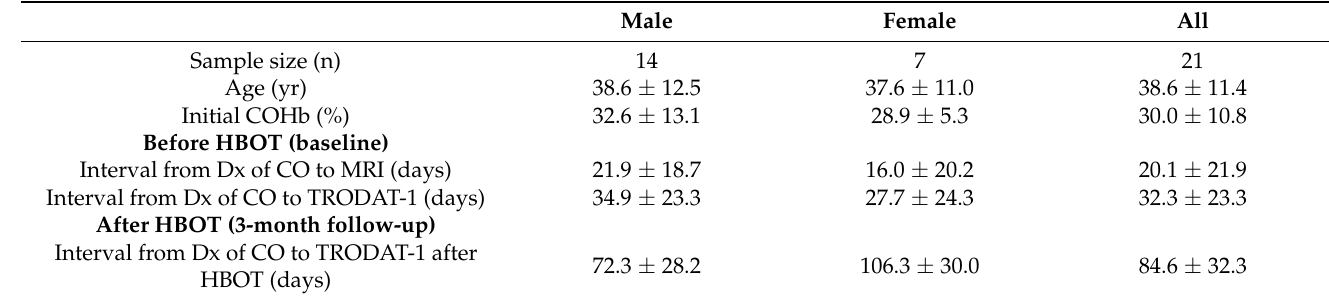
Table 1. Characteristics of the patients with carbon monoxide (CO)